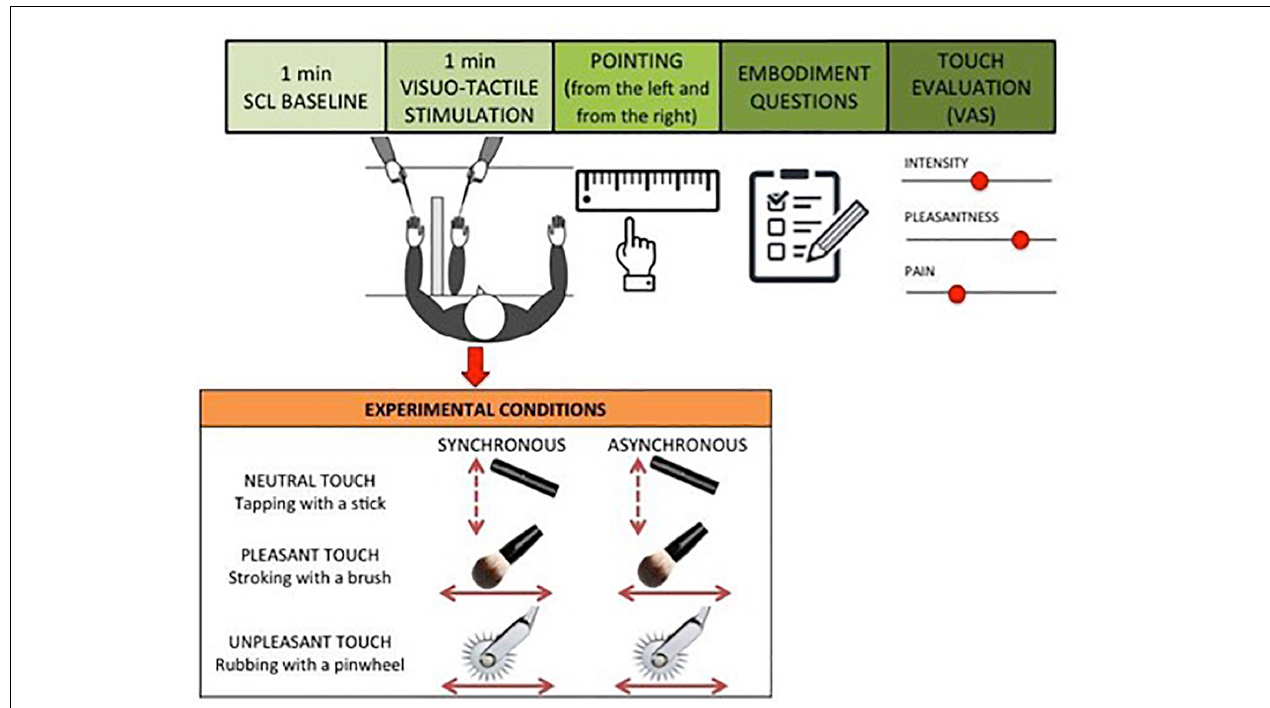
FIGURE 1 | Experimental paradigm. Each participant was presented with six experimental conditions, varying the synchrony between the touch on the real hand and the visual feedback on the rubber hand (synchronous vs. asynchronous) and the type of touch (pleasant touch vs. unpleasant vs. neutral touch). The order of the experimental conditions was randomized between